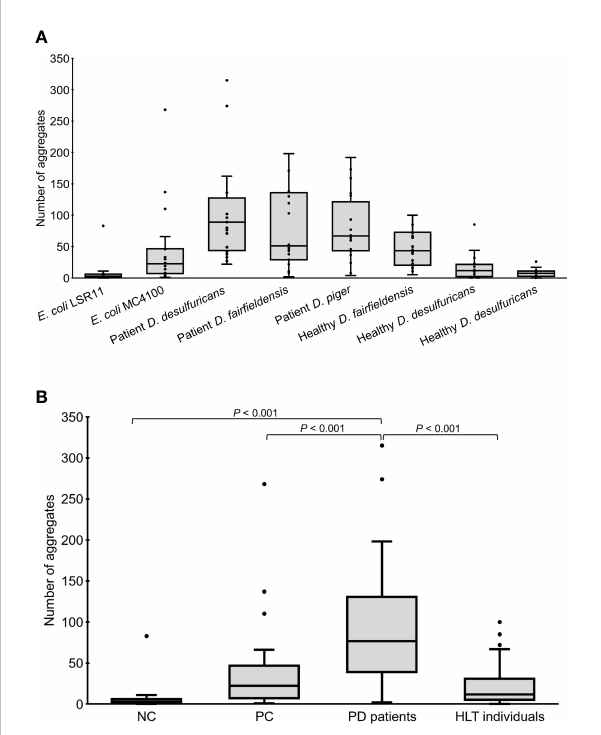
FIGURE 2 Number of alpha-syn aggregates in the head region of C. elegans at day 4 adult stage fed with different bacteria, demonstrated individually (A) or as groups (B) . NC: E. coli LSR11 (negative control), PC: E. coli MC4100 (positive control), PD patients: DSV strains from patients with Parkinson ’ s disease, HLT individuals: DSV strains from healthy individuals. Twenty worms per bacterial diet were analyzed. The dots represent the worms that were analyzed (A) or outliers (B) . The boxes represent the fi rst and third quartile (lower and upper edges, respectively) and the medians (horizontal line within the boxes).